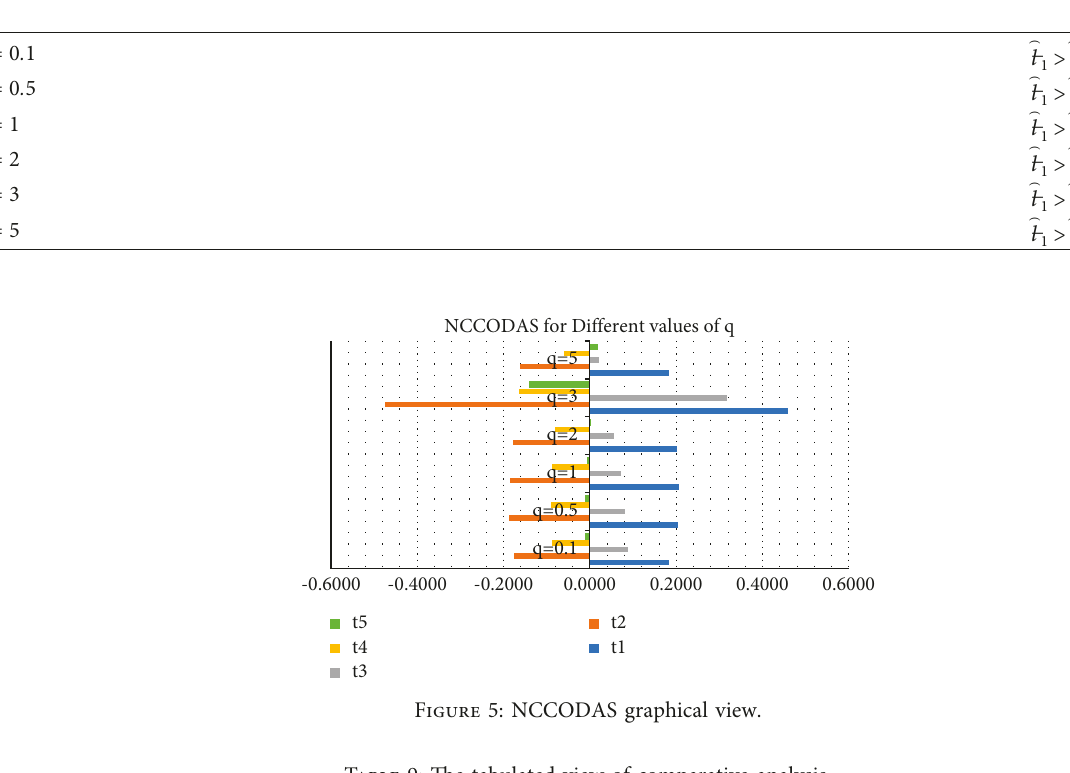
Table 8: The graphical interpretation of all alternatives subject to the different values of q . Tabulated view of NCCODAS for different values of q